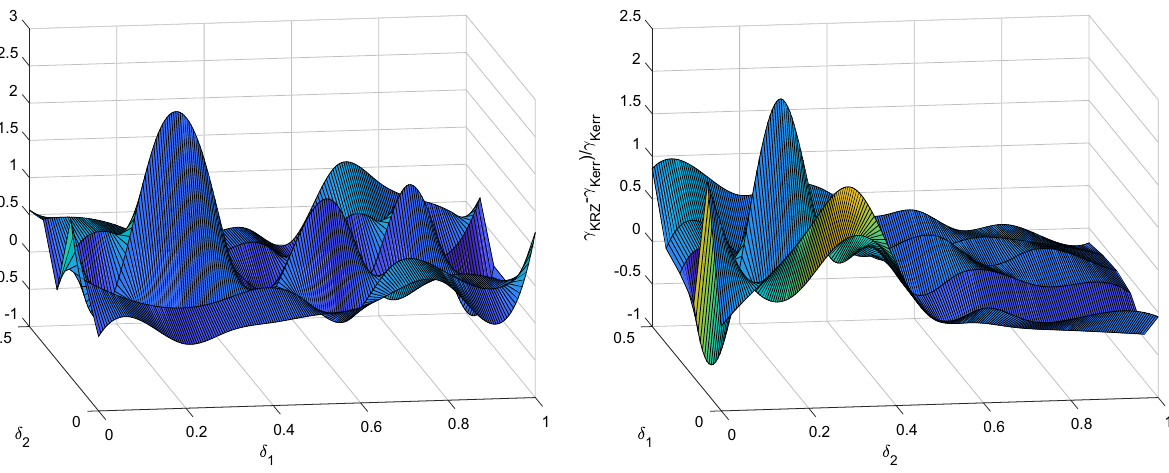
Fig. 3 Relative differences of LEs between the KRZ and Kerr cases as respond to the dependence from δ 2 ranging from 0 to 1 and δ 1 ranging functions of δ 1 and δ 2 . Left panel corresponds to the dependence from from 0 to 0 . 5. Both panels can be regarded as 3D figures observed in δ δ . 5. Right panel cor- different directions but the values of the coordinate axes are 1 ranging from 0 to 1 and 2 ranging from 0 to 0